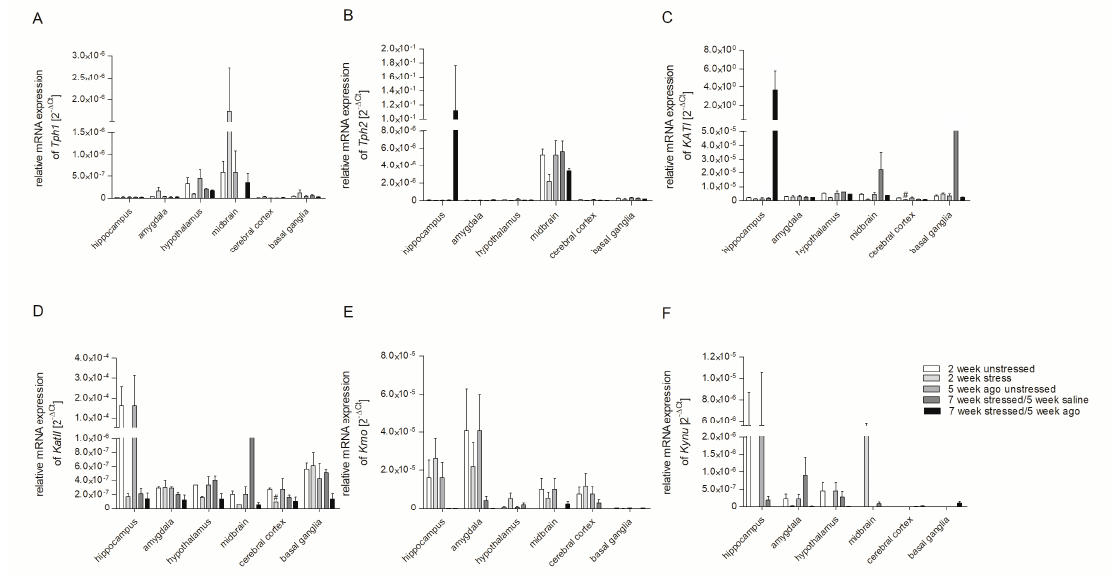
Figure 3. Tph1 ( A ) , Tph2 ( B ), KatI ( C ), KatII ( D ), Kmo ( E ), and Kynu ( F ) mRNA expression in six brain structures (hippocampus, amygdala, hypothalamus, midbrain, cerebral cortex, and basal ganglia) of rats exposed to CMS for two weeks (2 weeks unstressed, 2 week stressed) and in animals exposed to CMS for seven weeks and administered vehicle (1 mL / kg) or agomelatine (10 mg / kg) for five weeks (5 weeks agomelatine unstressed, 7 weeks stressed / 5 weeks saline and 7 weeks stressed / 5 weeks agomelatine). Relative gene expression levels were estimated using the 2 − ∆ Ct (Ctgene–Ct18S) method; n = 6; # p < 0.05 for di ff erences between 2 weeks stressed and 2 weeks unstressed groups.